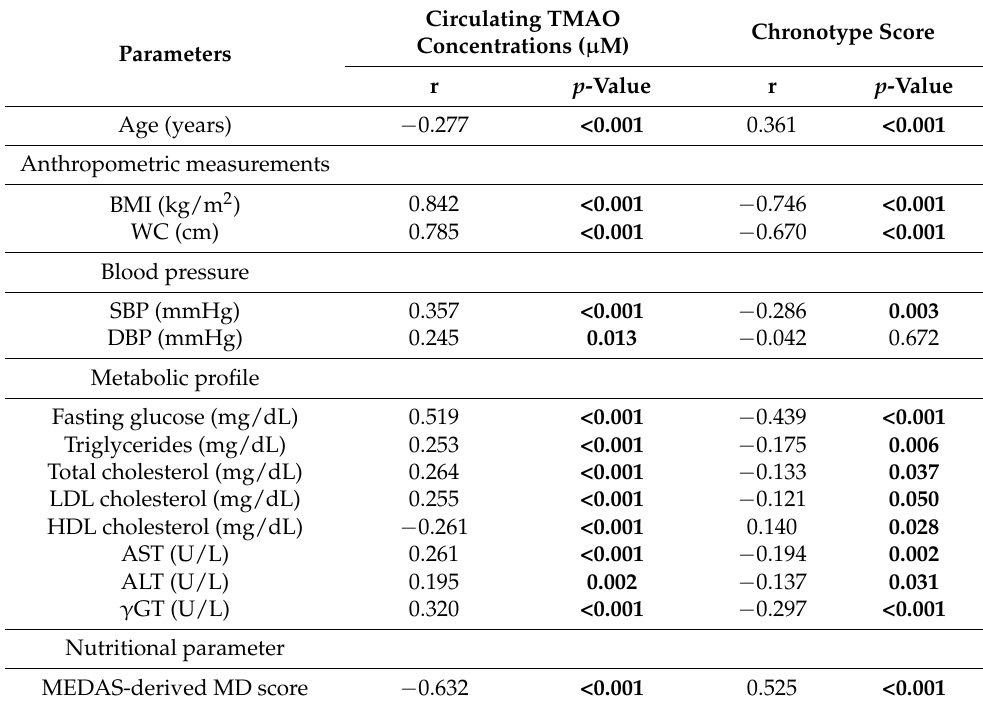
Table 4. Correlations between circulating TMAO concentrations with chronotype scores, age, BMI, WC, blood pressure, metabolic profile, and MEDAS-derived MD